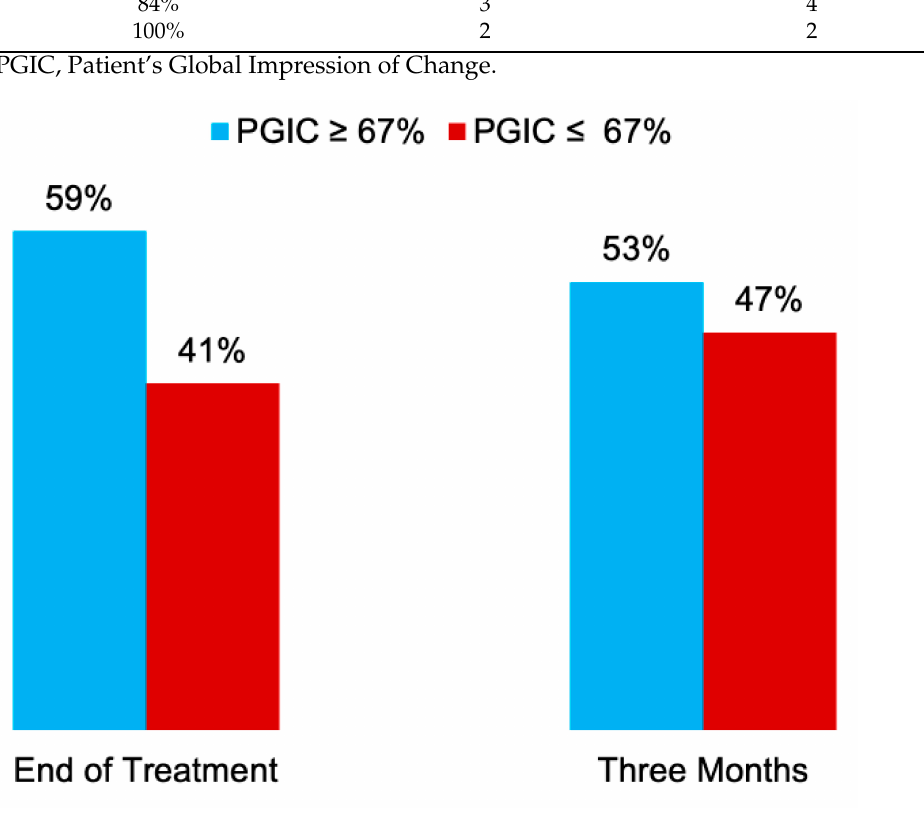
Figure 1. Proportion of patients reporting a PGIC ≥ 67% at the end of treatment and 3 months after the end of treatment. PGIC, Patient’s Global Impression of Change .